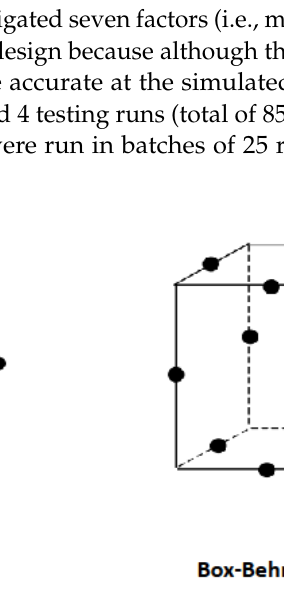
Figure 5. Two types of experimental designs.